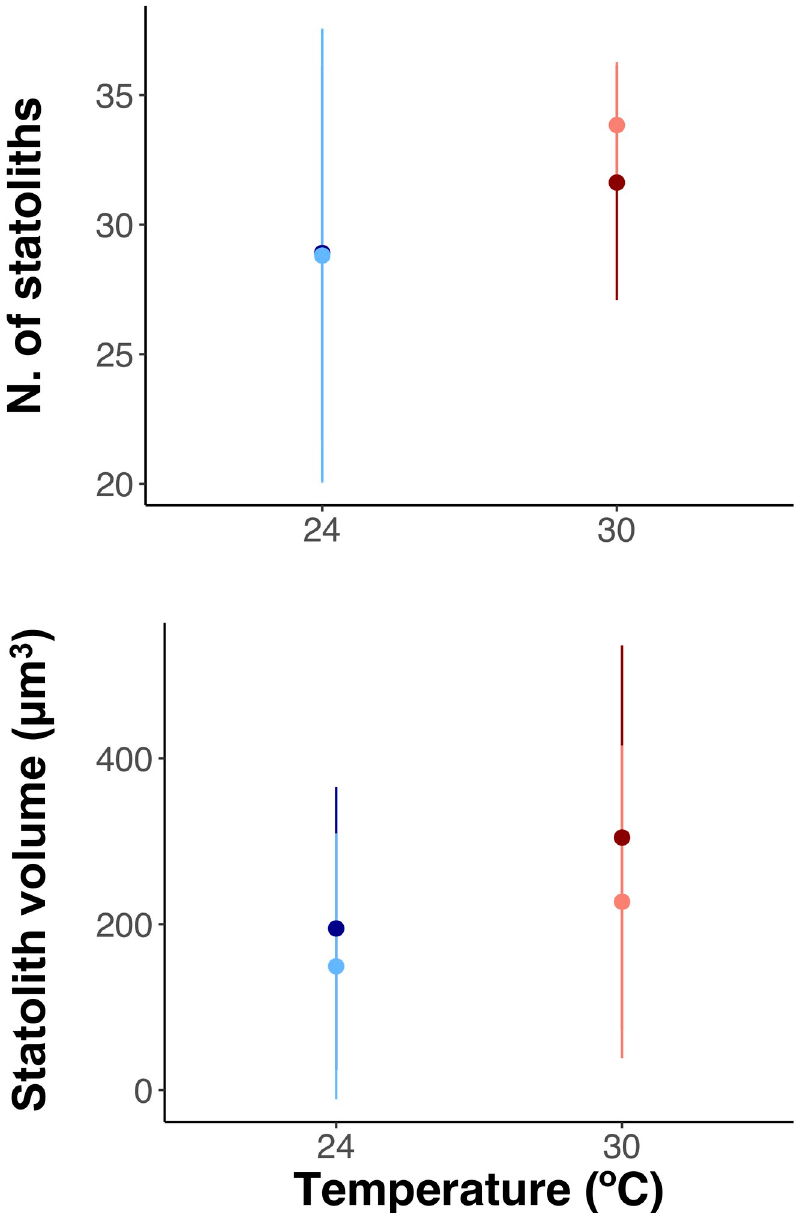
Fig 5. Number of statoliths per rhopalium (A) and volume of statoliths ( μ m 3 ) (B) under the different temperature (24˚C and 30˚C) and pH (ambient and future) treatments. Light blue for 24˚C and pH 7.99, dark blue for 24˚C and pH 7.71, light red for 30˚C and pH 8.01 and dark red for 30˚C and pH 7.73. Error bars represent standard deviation (SD). temperature and that bigger statoliths will be formed at elevated temperatures. Finally, we found that the density of zooxanthellae in C . tuberculata tissues was not impacted by experi- mental treatment conditions.